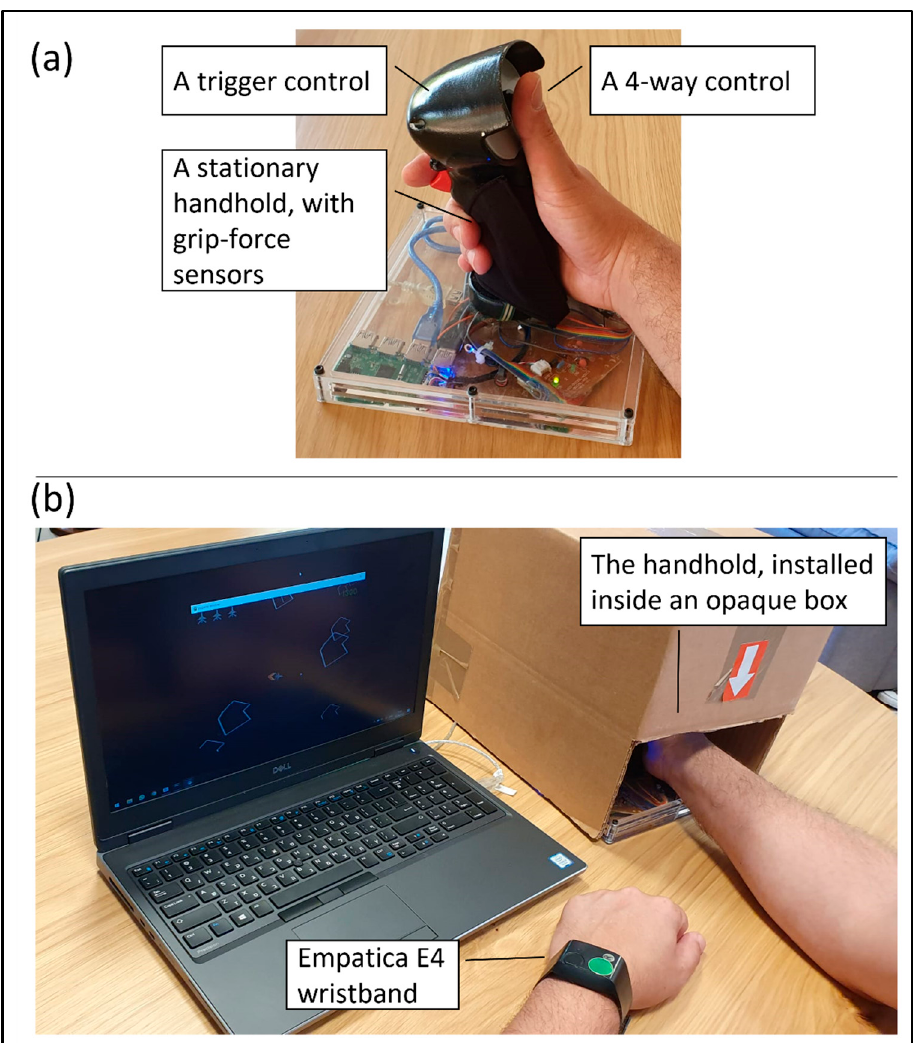
Figure 1. ( a ) The stationary handhold including the grip force sensors and two controls: a 4-way and a trigger; ( b ) general setup, consisting of a laptop with the “Asteroids” game, operated via the controls placed on the handhold, installed inside an opaque box with a hand hole for the right hand and an Empatica E4 wristband on the left hand.